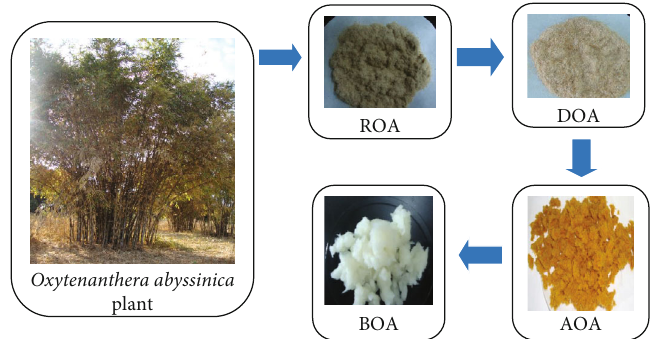
Figure 5: Photograph of the Oxytenanthera abyssinica plant with di ff erent treatment stages.